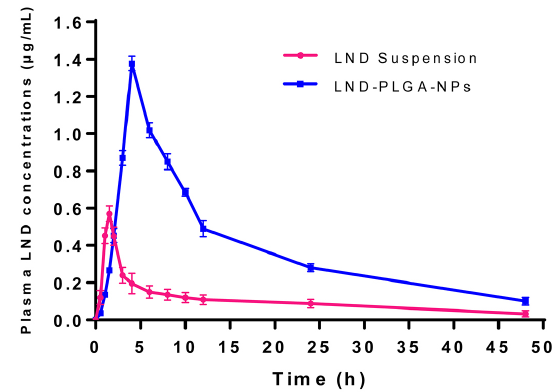
FIGURE 9 - Mean plasma concentration time profiles of lenalidomide in wistar rats: (a) lenalidomide suspension (b) lenalidomide PLGA-NPs with (mean±SD,